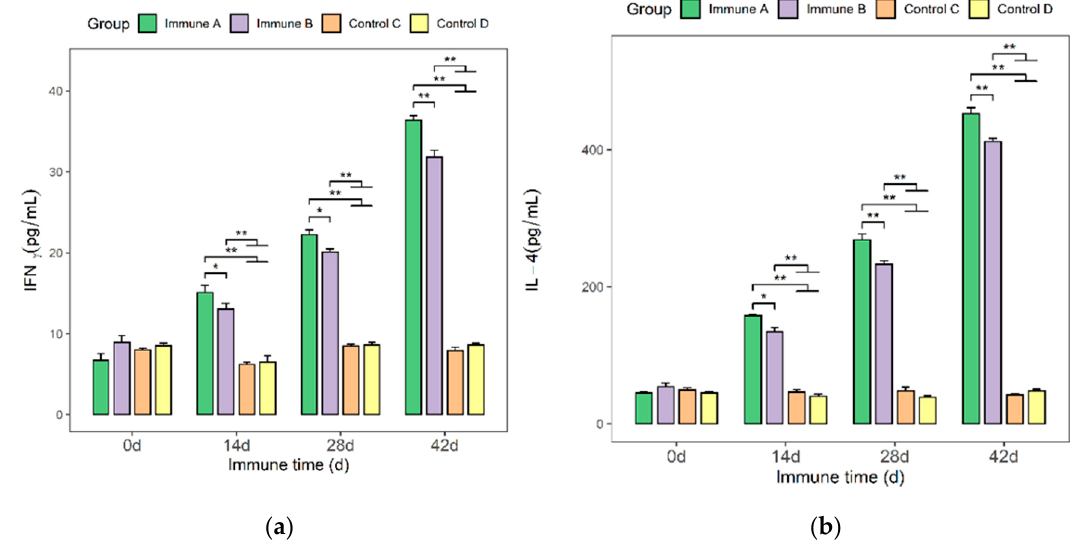
Figure 4. Serum IFN- γ and IL-4 levels in mice from different immunization groups. Each mouse in each group ( n = 5 per group) was screened for IFN- γ and IL-4. Statistical comparisons were made between groups at all stages of immunization. ( a ) On day 14, IFN- γ levels in immune groups A and B were significantly increased ( p < 0.05). ( b ) On day 14, the levels of IL-4 in immune groups A and B were significantly increased ( p < 0.05). * p < 0.05 presents a significant difference, and ** p < 0.01 shows a highly significant difference.